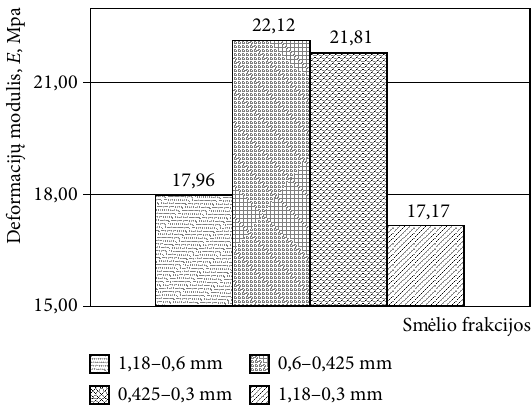
Fig. 13. Deformation modulus of different sand